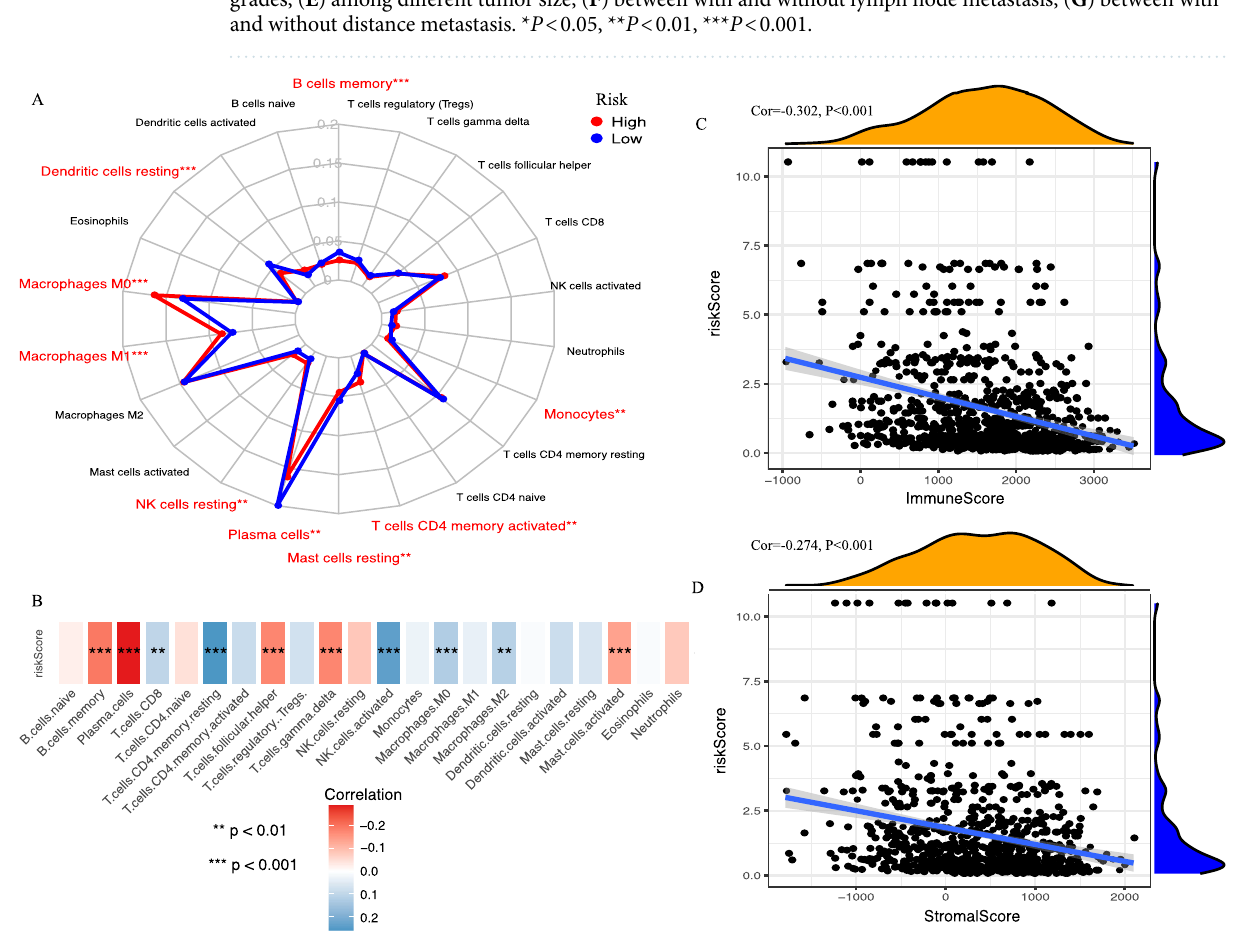
Figure 7. Relationship between the IRGPs signature and tumor-infiltrating immune cells (TIICs). ( A ) The difference of 22 TIICs between high- and low- risk group. ( B ) The Spearman correlation analysis revealed the relationship of immune risk scores to 22 TIICs. The Spearman correlation analysis revealed the relationship of immune risk scores to ( C ) immune scores and ( D ) stromal scores. * P < 0.05, ** P < 0.01, *** P <